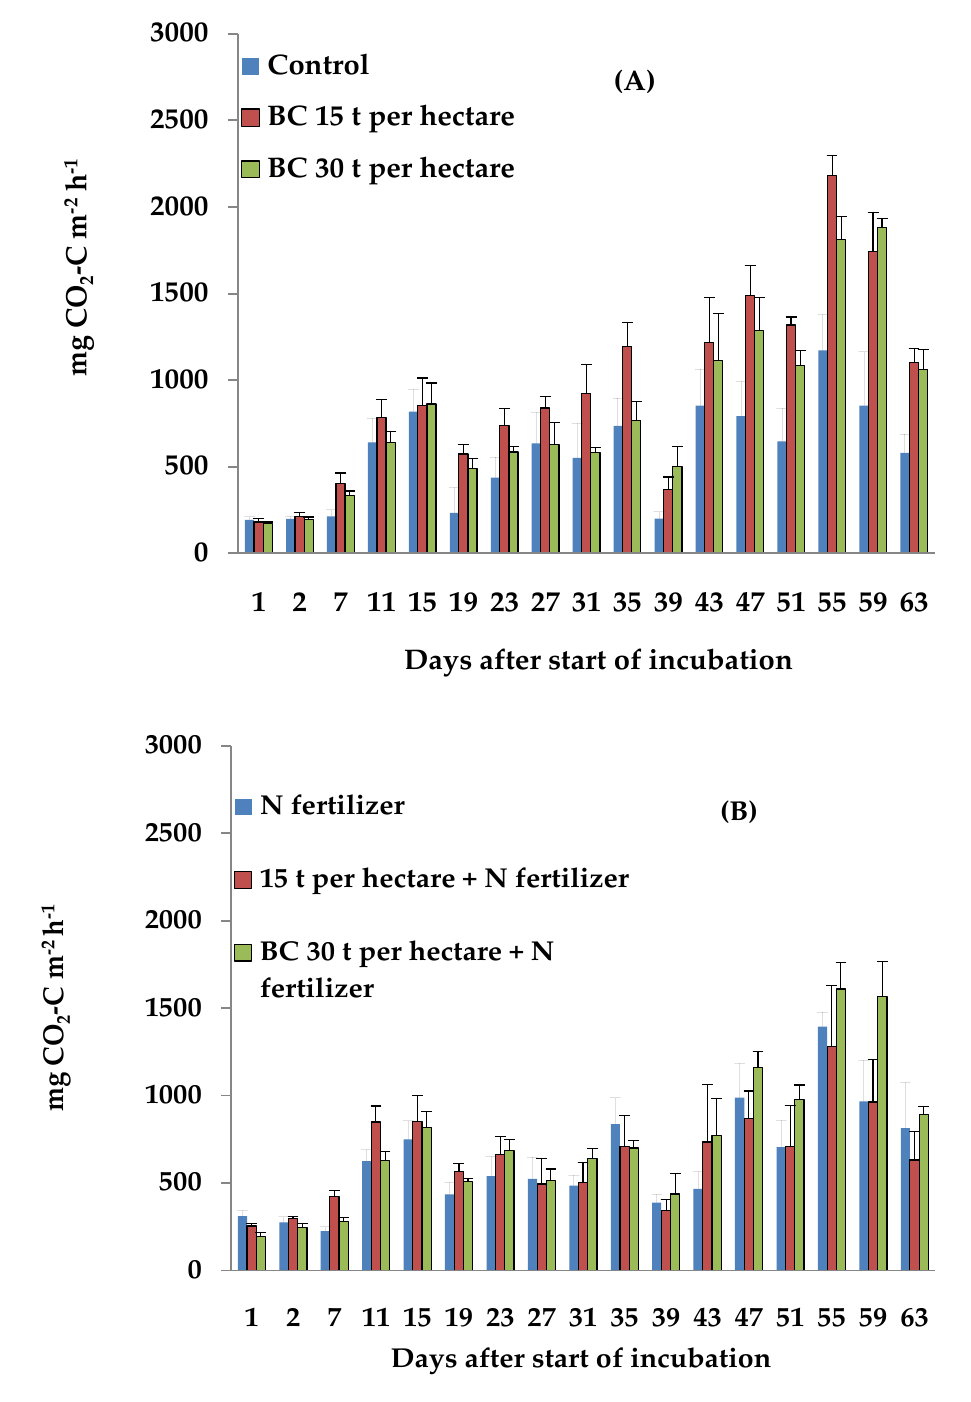
Figure 2. Dynamics of daily CO 2 emissions from the clayey loam soil with ( A ) no N fertilizer and ( B ) with N-fertilizer, during the incubation period. Error bars show the standard error of the mean for each treatment ( n = 6).